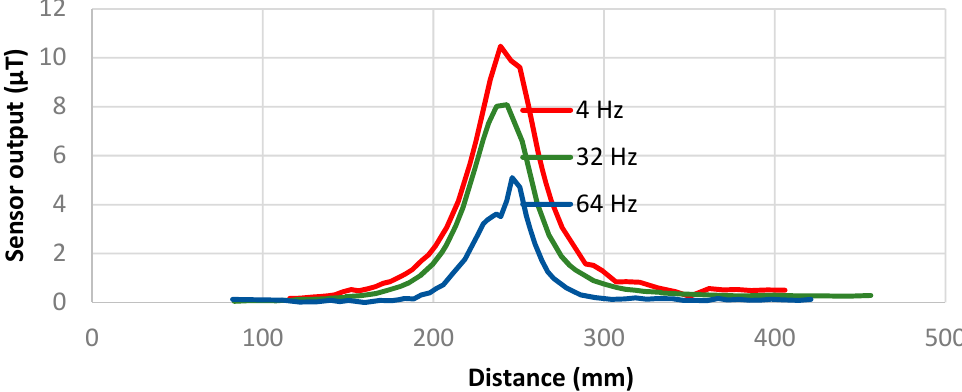
Figure 5. Single sensor output vs. piston position for excitation frequency of 4 Hz, 32 Hz and 64 Hz.